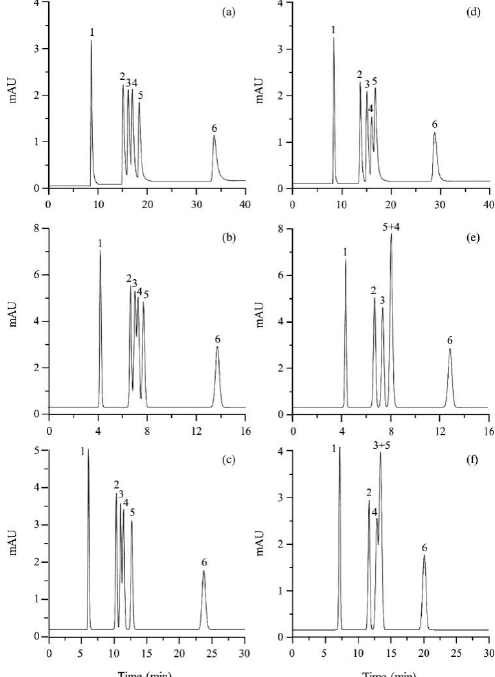
Figure 7. Simulated chromatograms for mixtures of the six TCAs using the C18 ( a – c ) and C8 ( d – f ) columns. Mobile phase composition: ( a , d ) 30% acetonitrile, ( b , e ) 30% acetonitrile/10 mM HMIM·Cl, and ( c and f ) 30% acetonitrile/10 mM HMIM·BF 4 . Peak identity: (1) doxepin, (2) imipramine, (3) nortryptiline, (4) maprotiline, (5) amitryptiline, and (6) clomipramine. Figure adopted from reference [147] with permission of the copyright holder.